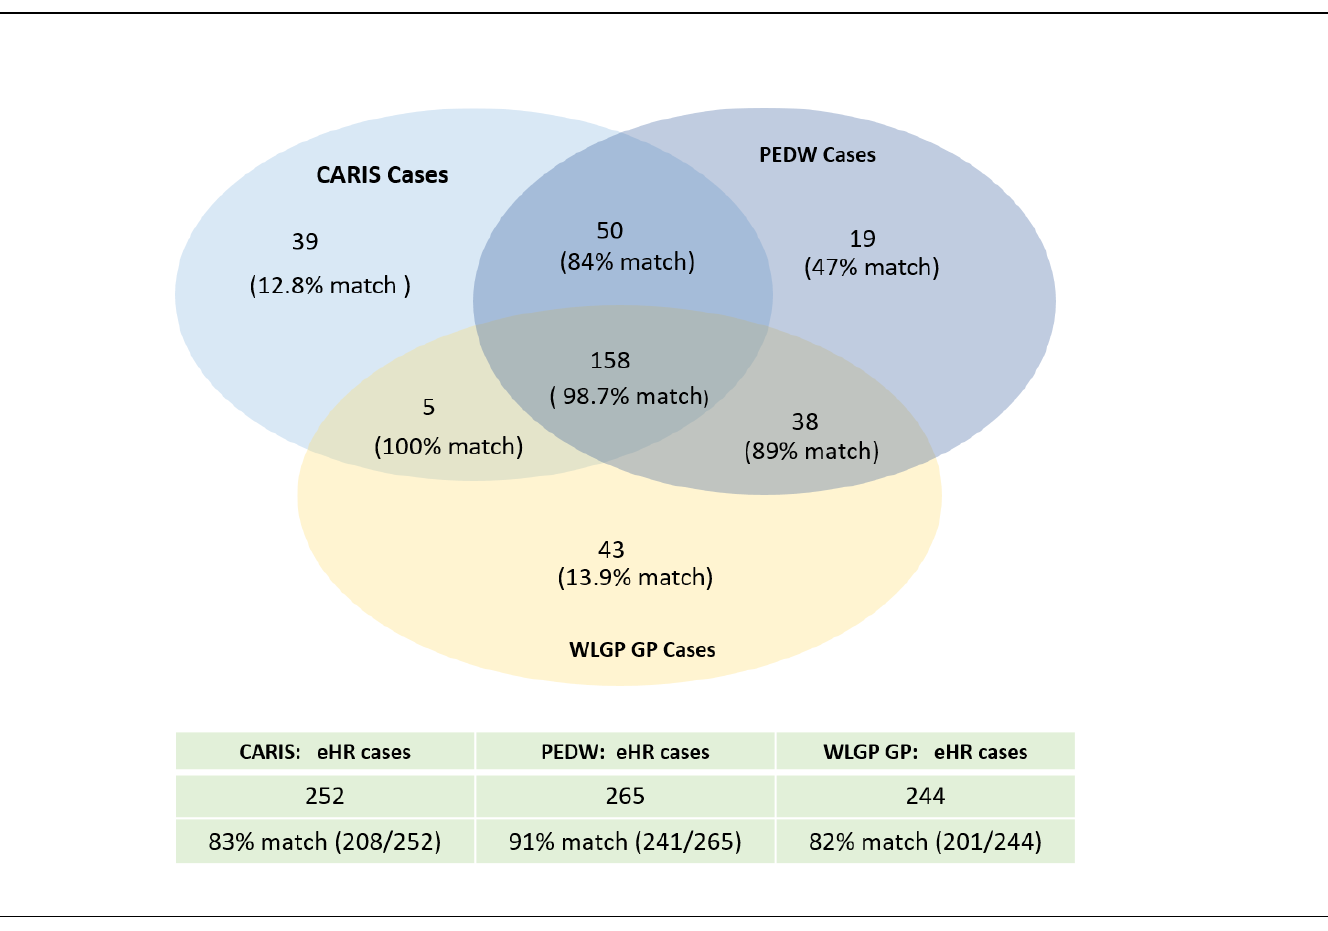
Figure 2: This diagram shows the number of children with CF codes in CARIS, PEDW and WLGP and the percentage of children matched to the UK CF Registry data. The table at the bottom of the figure gives the total number of cases identified in each EHR data source and the percentage of children found in the UK CF